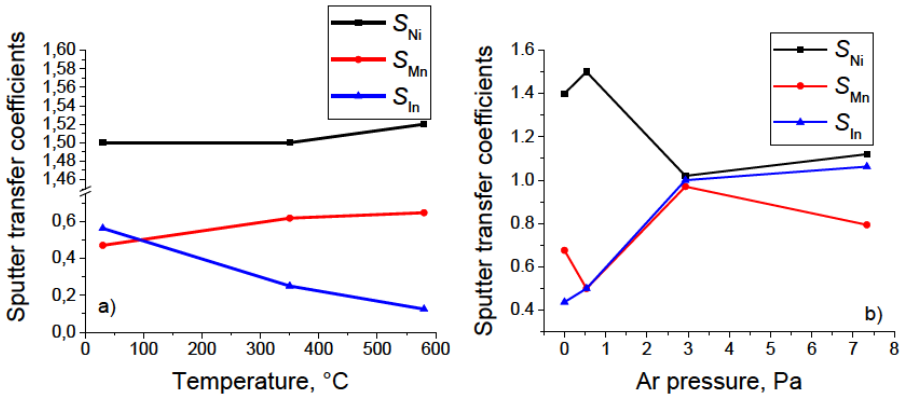
Figure 1: The dependency of sputter transfer coeflcient S on the substrate temperature (a) and pressure of buffer Ar gas at room tempera- ture (b) during the deposition of samples from Ni